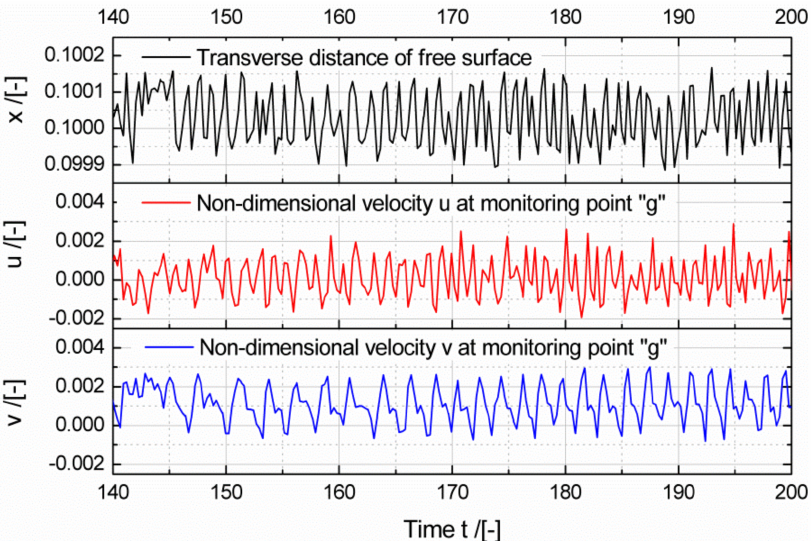
Figure 9. Variations of velocity and corresponding displacement of free surface at monitoring point g ( Ca C = − 0.01, R = 2.5 mm, H/R = 1.0, Vr =